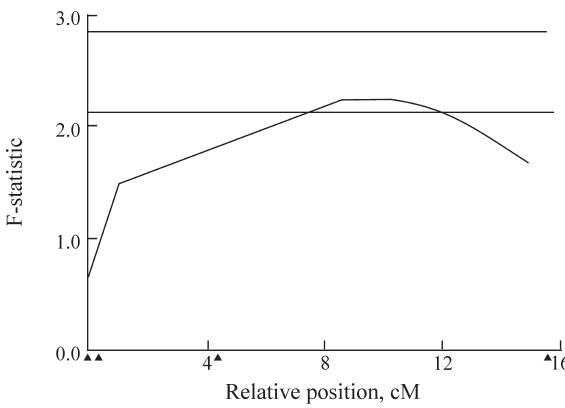
Figure 2 - F-statistic profile for body weight in the analyzed interval of 15.5 cM. The upper horizontal line represents a significance level of 0.01 and the lower represents a significance level of 0.05 (F-statistic = 2.25 at 82.9 cM). Arrowheads under the X-axis indicate the relative position of the markers on the chromosome, beginning at the centromeric extremity. From left to right: ILSTS066 (72.9 cM), IGF-1 (73 cM), TEXAN15 (77.2cM) and BMS1248 (88.4cM).